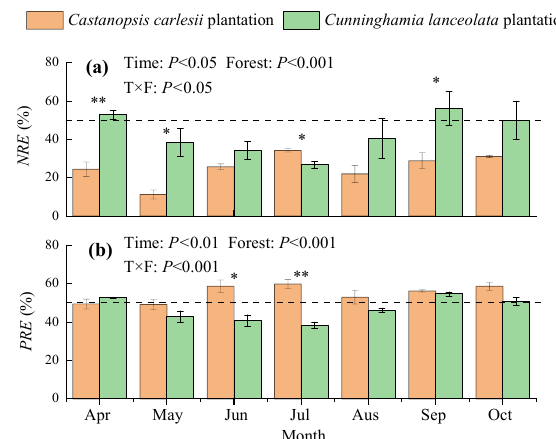
Figure 4. Leaf N ( a ) and P ( b ) resorption efficiencies. NRE : Nitrogen resorption efficiency, PRE : Phosphorus resorption efficiency. Each column represents the average value of the three replicates ( n = 3). Error bars represent standard errors (SE) . The p values show the results from repeated measures ANOVA testing for the effect of forest type over time. Asterisks denote significant differences between forest types: * p < 0.05, ** p < 0.01. The dotted line represents the 50% threshold.